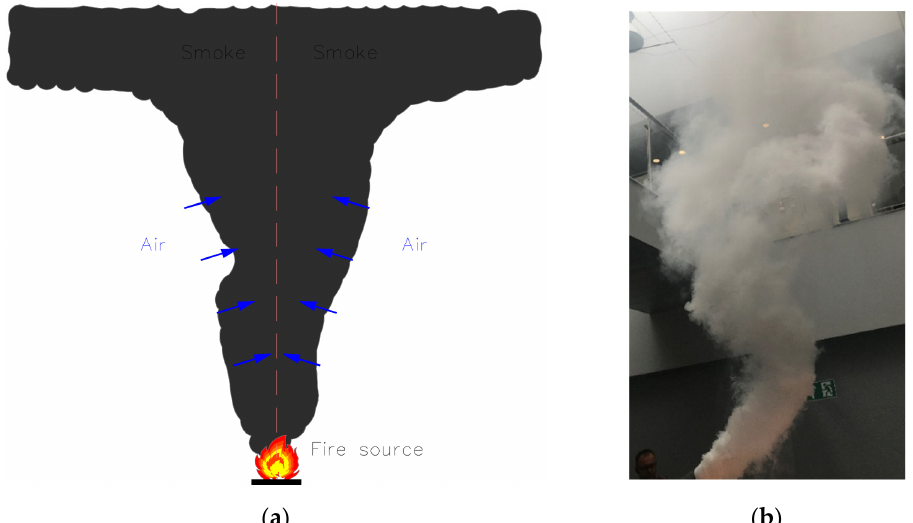
Figure 1. A convective smoke column: ( a ) a theoretical free smoke column shape ( b ) a photo of a free smoke column from the smoke test (photo D. Brzezi ń ska).